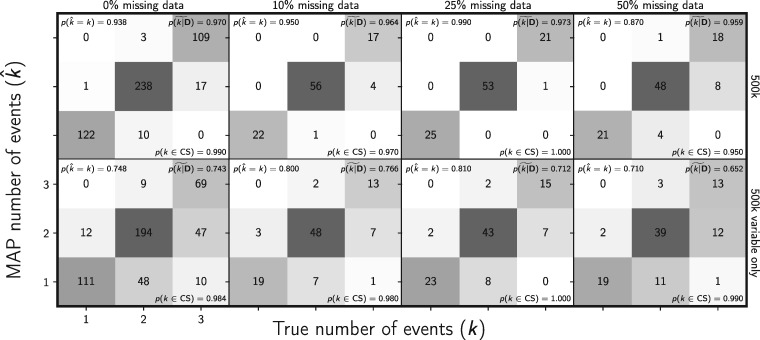
Assessing the effect of missing data on the ability of the new method to estimate the number of divergence events. The columns, from left to right, show the results when each simulated 500,000-character matrix has approximately 0%, 10%, 25%, and 50% missing cells. For comparison, the first column shows the results of the 500 data sets from Figure 4; the remaining columns show the results of 100 data sets. The rows show the results when (top) all sites and (bottom) only variable sites are analyzed. The number of data sets that fall within each possible cell of true versus estimated numbers of events is shown, and cells with more data sets are shaded darker. The estimates are based on the number of events with the maximum a posteriori (MAP) probability. For each plot, the proportion of data sets for which the number of events with the largest posterior probability matched the true number of events—\documentclass[12pt]{minimal}
\usepackage{amsmath}
\usepackage{wasysym}
\usepackage{amsfonts}
\usepackage{amssymb}
\usepackage{amsbsy}
\usepackage{upgreek}
\usepackage{mathrsfs}
\setlength{\oddsidemargin}{-69pt}
\begin{document}
}{}$p(\hat{{k}} = {k})$\end{document}—is shown in the upper left corner, the median posterior probability of the correct number of events across all data sets—\documentclass[12pt]{minimal}
\usepackage{amsmath}
\usepackage{wasysym}
\usepackage{amsfonts}
\usepackage{amssymb}
\usepackage{amsbsy}
\usepackage{upgreek}
\usepackage{mathrsfs}
\setlength{\oddsidemargin}{-69pt}
\begin{document}
}{}$\widetilde{p({k}|{\mathbf{D}})}$\end{document}—is shown in the upper right corner, and the proportion of data sets for which the true number of events was included in the 95% credible set—\documentclass[12pt]{minimal}
\usepackage{amsmath}
\usepackage{wasysym}
\usepackage{amsfonts}
\usepackage{amssymb}
\usepackage{amsbsy}
\usepackage{upgreek}
\usepackage{mathrsfs}
\setlength{\oddsidemargin}{-69pt}
\begin{document}
}{}$p({k} \in \textrm{CS})$\end{document}—is shown in the lower right. All simulated data sets had three pairs of populations. We generated the plot using matplotlib Version 2.0.0 (Hunter 2007)